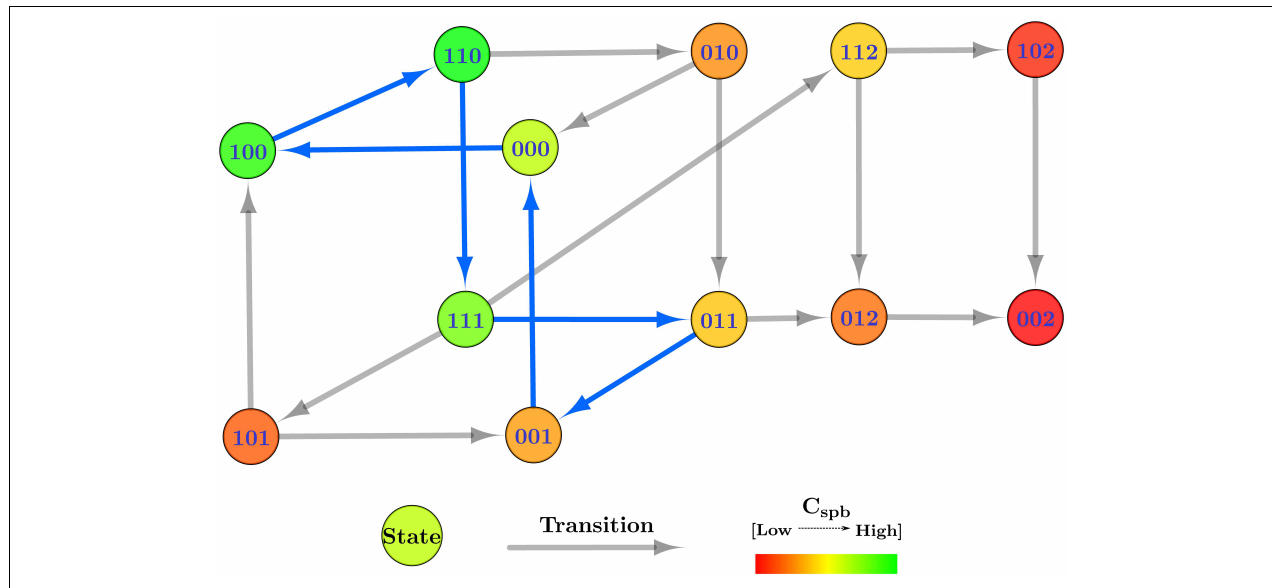
FIGURE 4 | Centrality applied state graph of Case Study 1: Microbial population. The cycle selected for hybrid modeling is shown via blue state